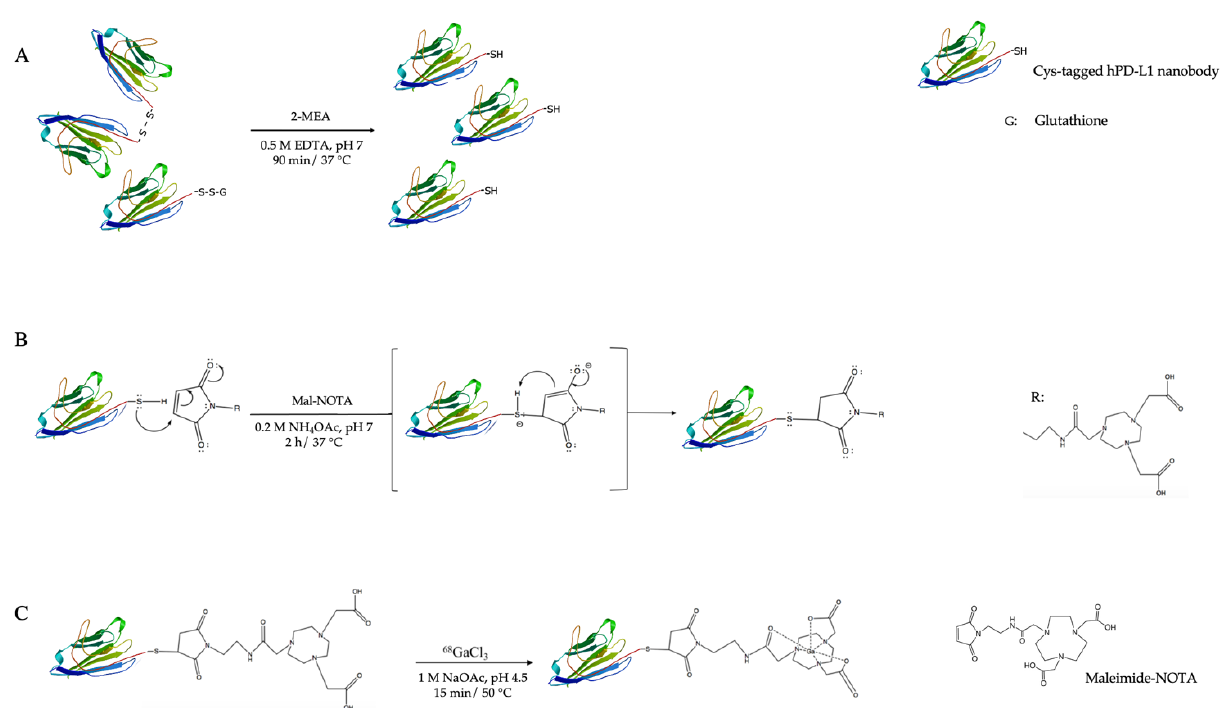
Figure 1. Representation of the functionalization and radiolabeling of the hPD-L1 Nb: ( A ) Dimerized Nbs are reduced in mild conditions (2-MEA = 2-mercaptoethylamine); ( B ) Site-specific functionalization of the Nb’s C-terminal cystein-tag with maleimide-NOTA via a Michael addition; ( C ) Gallium-68 labeling of the NOTA-mal-(hPD-L1) Nb.